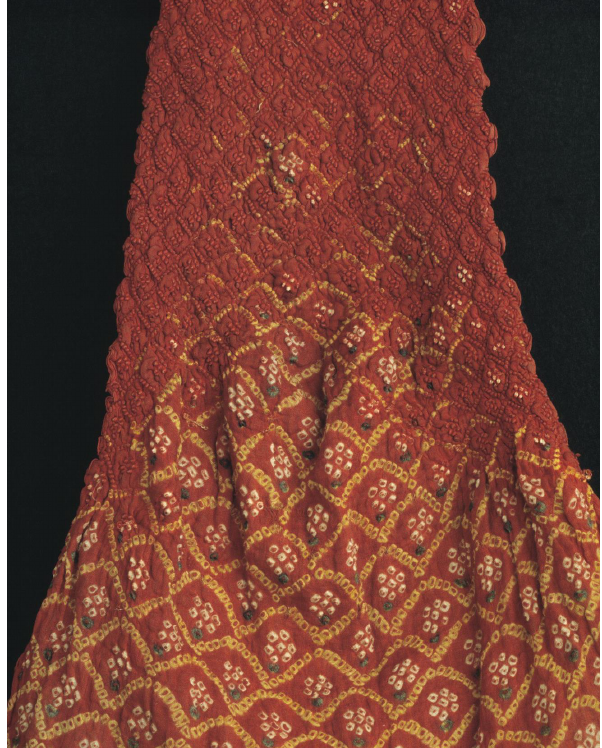
Figure 4 Figure 4. Turban cloth, tie-dyed cotton (c hunnar¯ı ), Kot ¯ a, c. 1860, 7885(IS). © Victoria and Albert